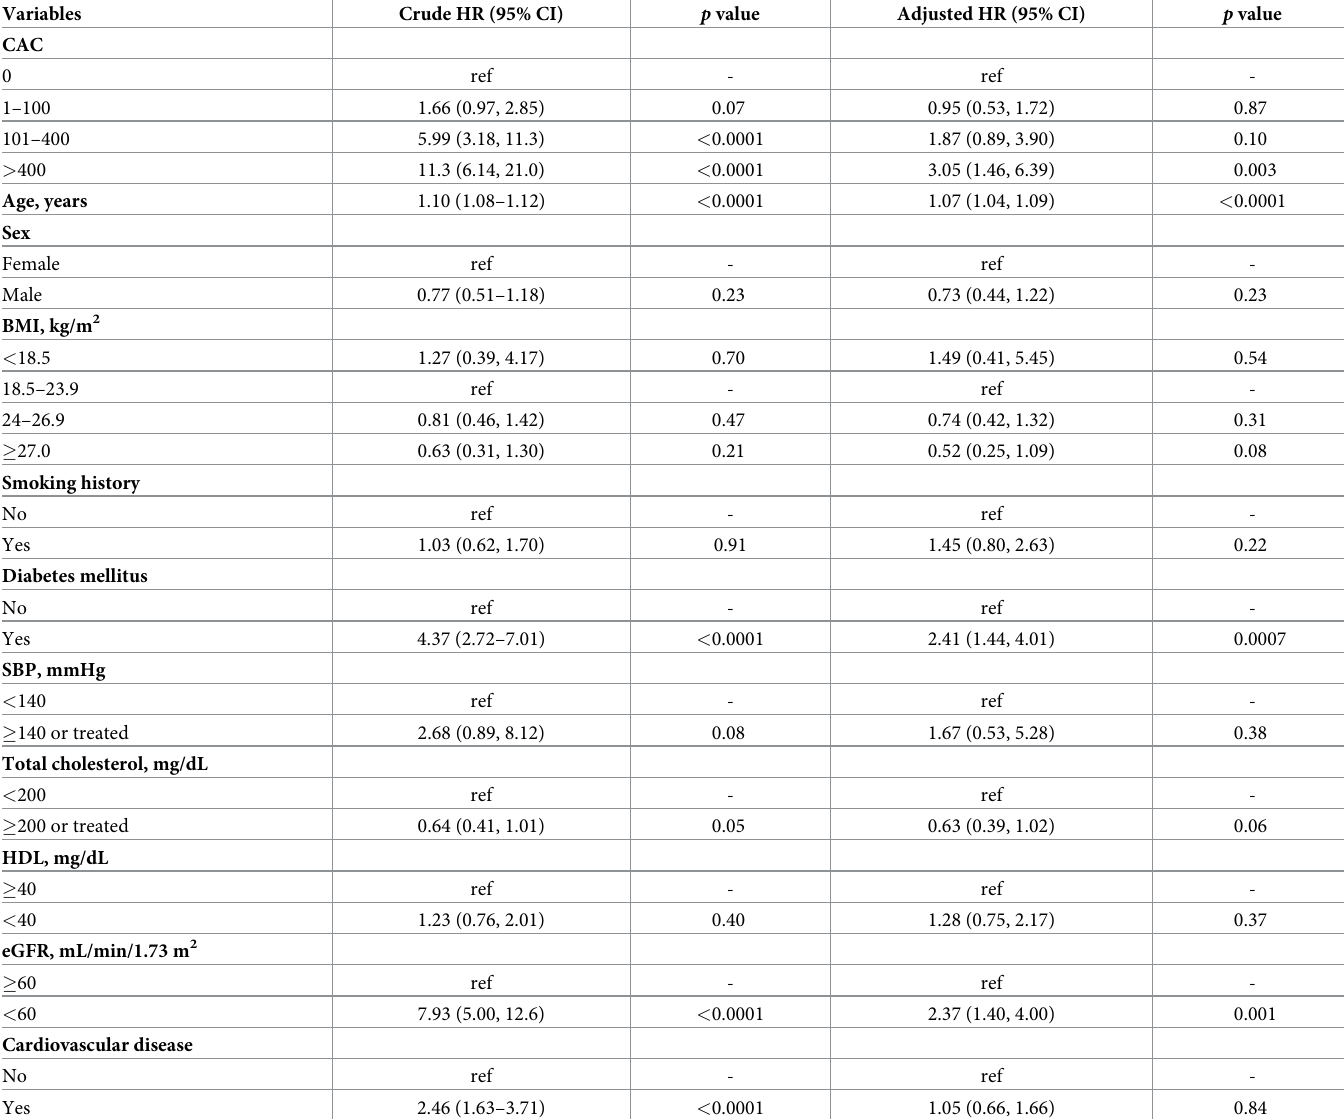
Table 2. All-cause mortality risks according to CAC and other risk